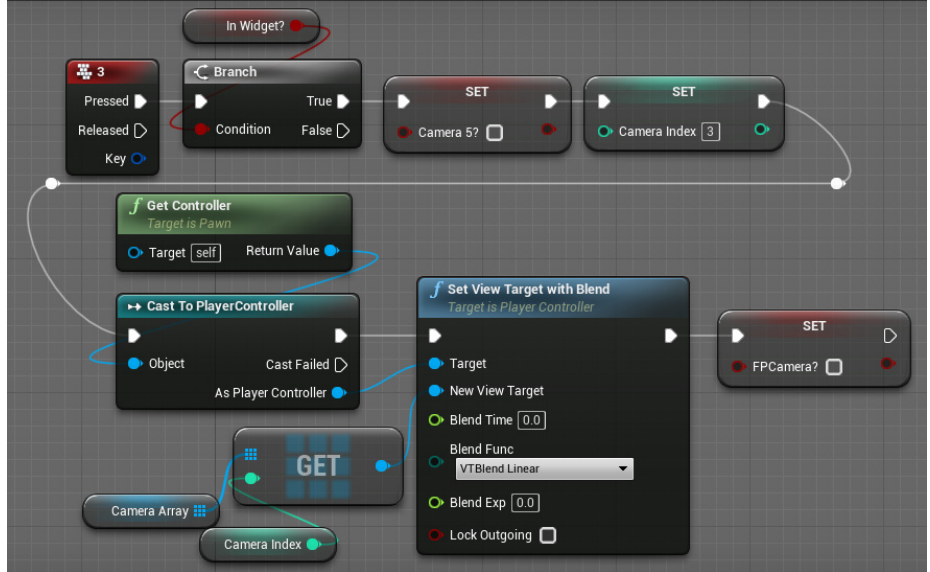
Figure 6. Change between Robot Cell cameras.